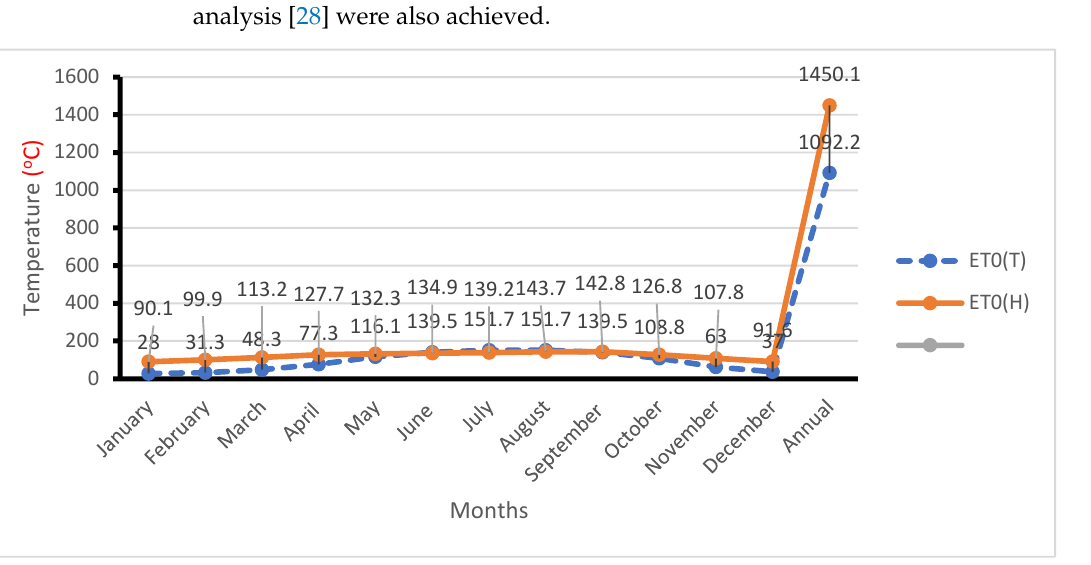
Figure 2. Potential evapotranspiration (ETo) at different temperature. T: mean daily air temperature at 2 m height (°C). H: mean height from sea lecel (m).